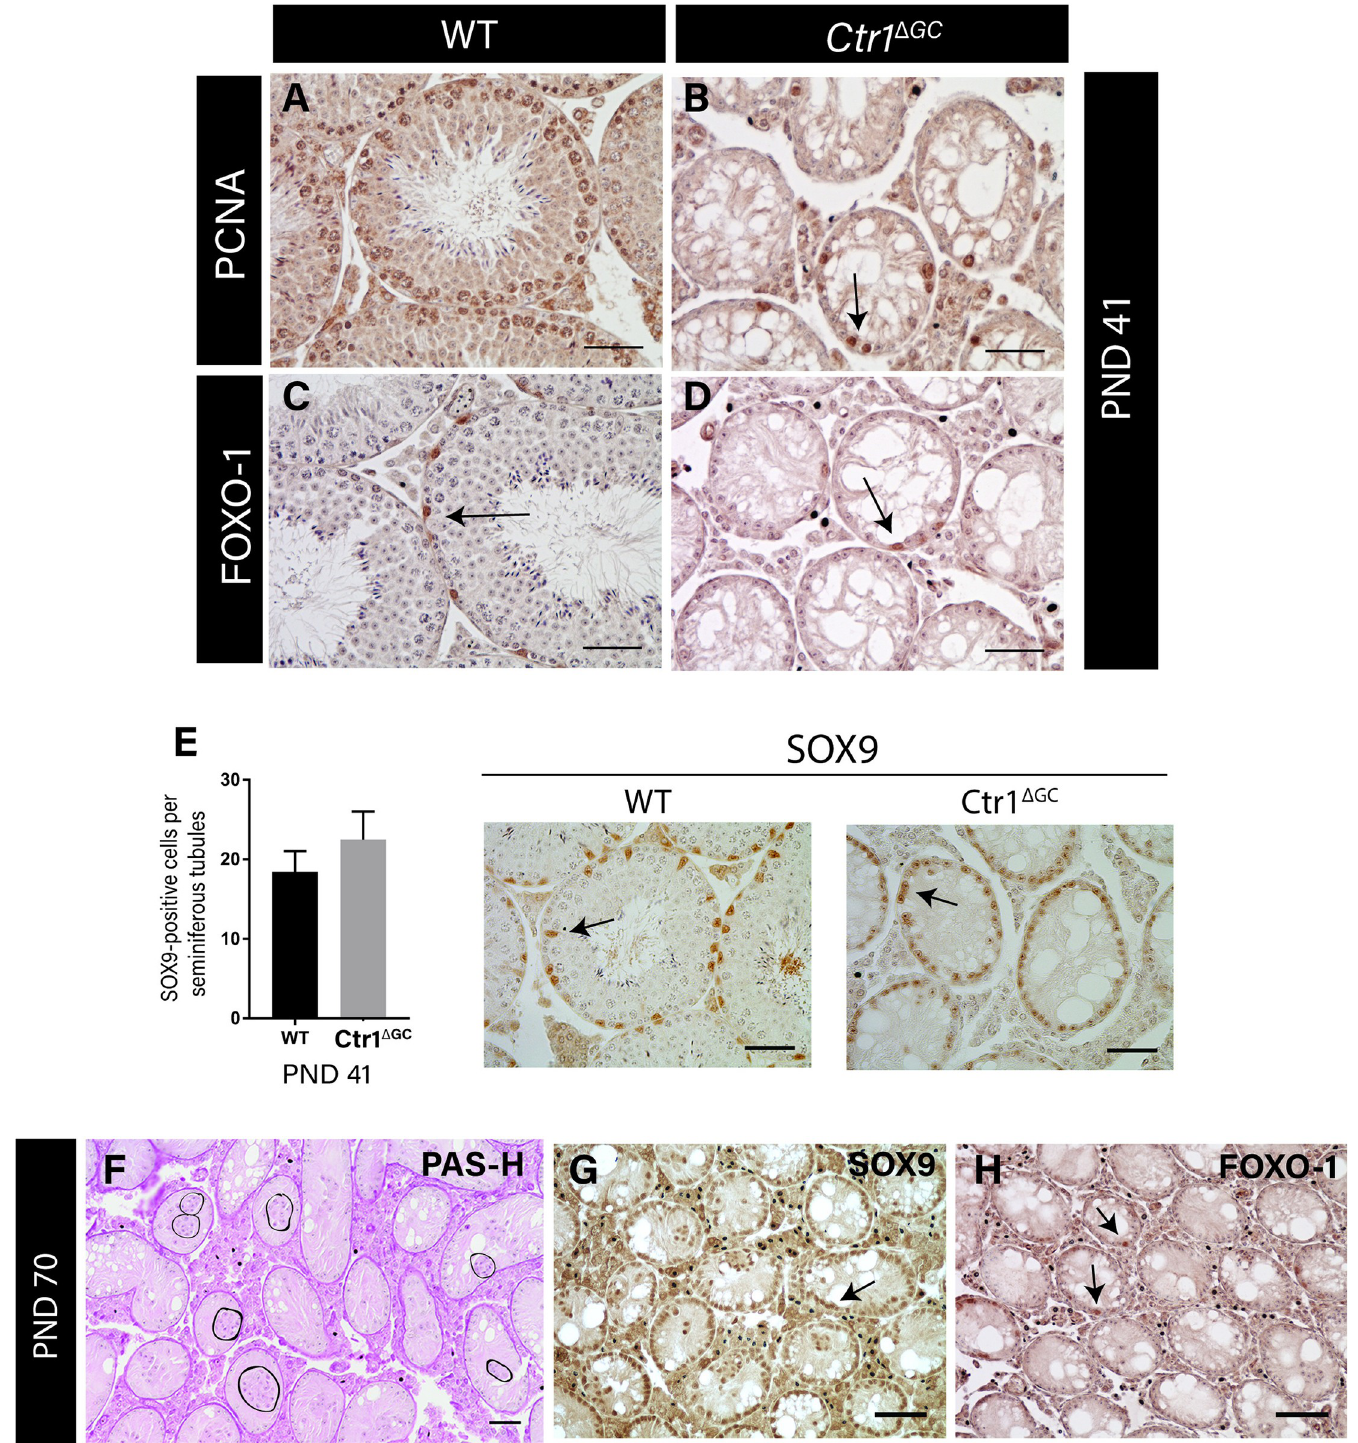
Fig 3. Ctr1 Δ GC mice at PND 41 display presence of undifferentiated spermatogonial cells and normal number of Sertoli cells in adult testes of Ctr1 Δ GC mice. Immunohistochemical nuclear staining for PCNA in GCs of both (A) WT and (B) Ctr1 Δ GC testes. Presence of FOXO-1 expressing undifferentiated spermatogonial cells at PND 41 in (C) WT and (D) Ctr1 Δ GC testes. Average number of SOX9-positive cells per seminiferous tubules (E). On right, representative immunohistochemical staining from SOX9 analysis of WT and Ctr1 Δ GC ; arrows indicating SOX9-positive SCs (Average ± SD, N = 3 for each genotype). Scale bar = 100 μ m. Histological analysis on Ctr1 Δ GC testis at PND 70 indicating multiple clusters of SCs in the lumen indicated by circles (F) with PAS-H staining. SOX9-positive SCs clarifying the SCs clusters in the lumen (G). (H) Presence of FOXO-1-positive spermatogonial cells, indicated by arrows, within the tubules of Ctr1 Δ GC testis at PND 70. Scale = 50 μ m.